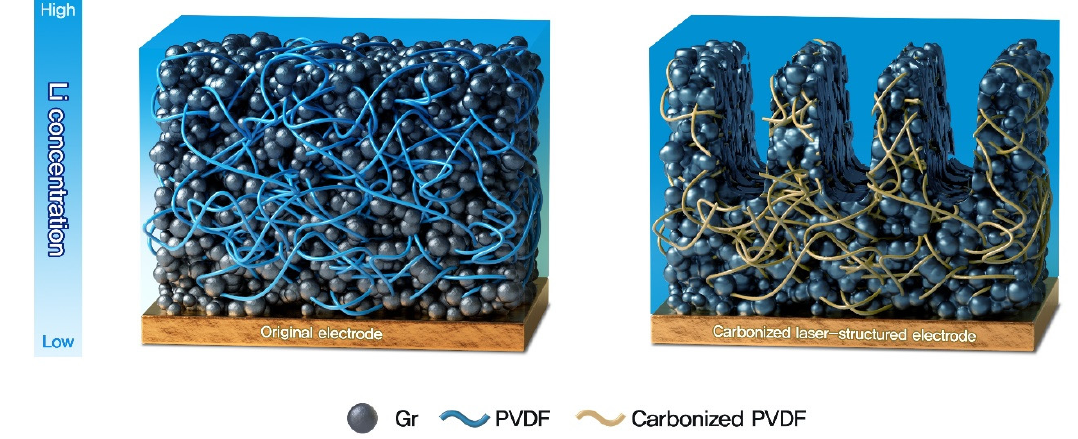
Figure 8. Schematic illustration of an original electrode and a PVDF-C-L electrode.